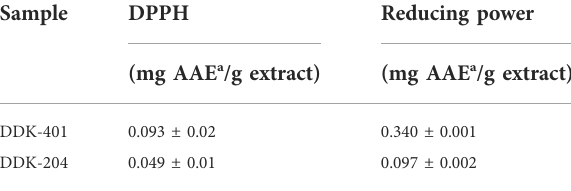
TABLE 4 Antioxidant capacity of DDK-401 and DDK-204.